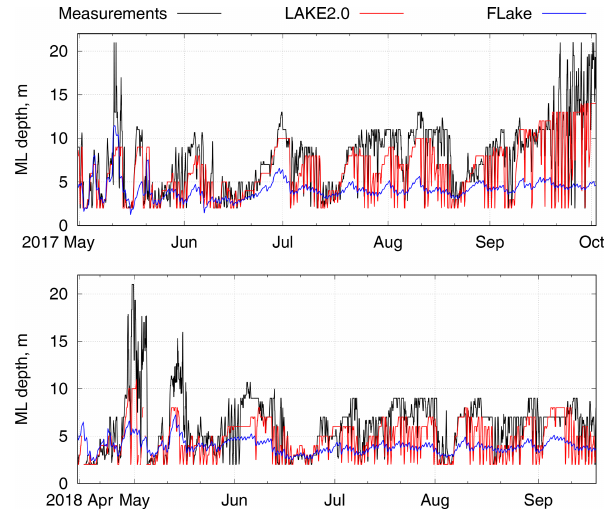
Figure 6. Evolution of mixed layer (ML) depth during stratification periods (with 6h moving